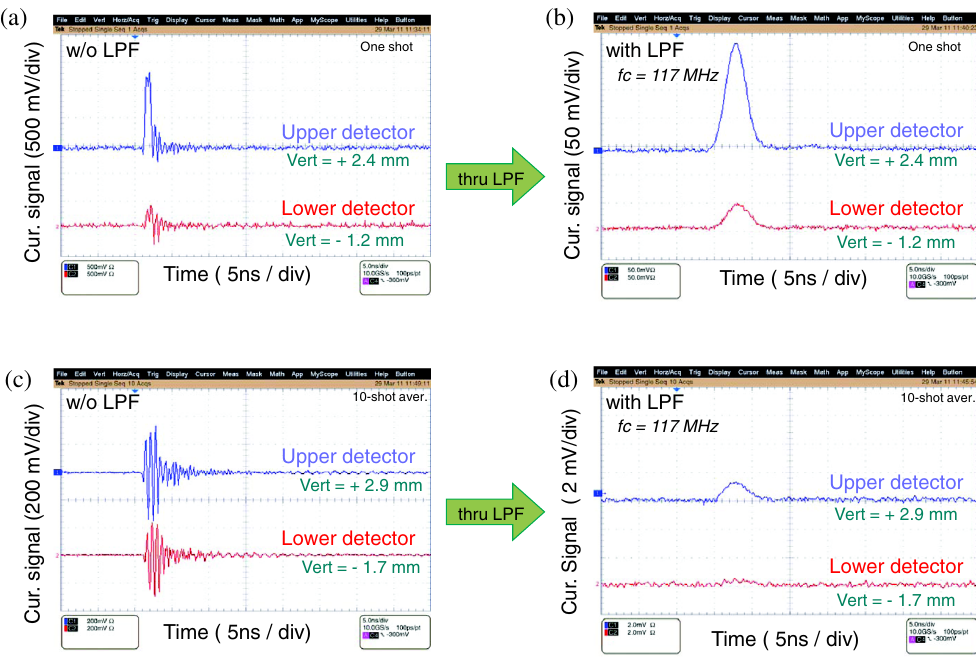
FIG. 19. Filtering of residual high-frequency components without ( w = o ) or with LPFs. (a) Large original current signal w = o LPFs, (b) large original current signal with LPFs, (c) small original current signal w = o LPFs, and (d) small original current signal with